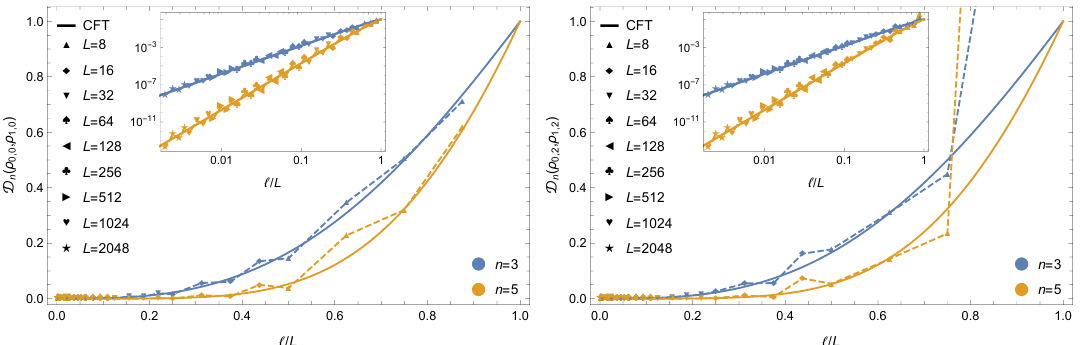
Figure 4 . Odd n -distance D n ( (cid:26); (cid:27) ) for n = 3 (blue) and n = 5 (yellow) as a function of the ratio between the subsystem ‘ and the system size L in the free compact boson theory. The solid lines are the analytic continuation (4.29) of the CFT prediction. The symbols (joined by dashed lines) are numerical data, with di(cid:11)erent symbols corresponding to di(cid:11)erent L . The two panels show two di(cid:11)erent pairs of vertex states (cid:26) and (cid:27) , but both with (cid:1) (cid:11) = 1. Insets: Zoom in log-log scale of the region ‘ (cid:28) L